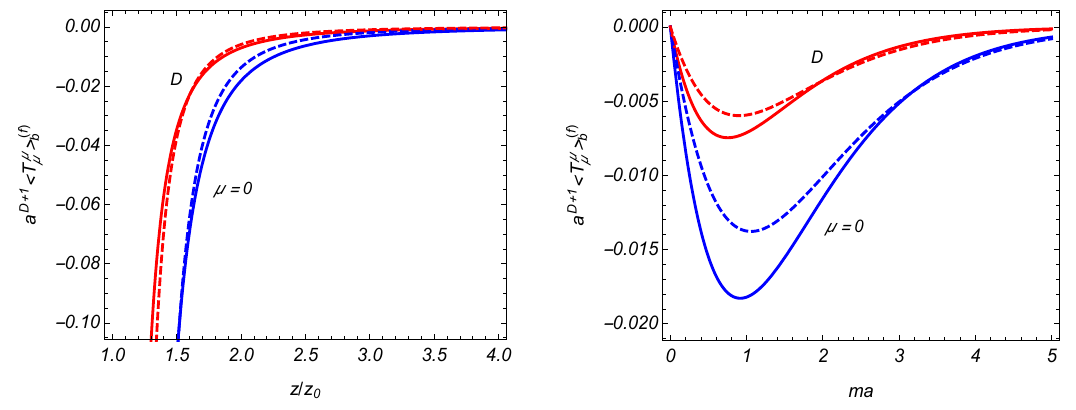
Figure 1. The brane-induced contributions in the VEVs of the energy density and the normal stress as functions: of z / z 0 ( left ); and of ma ( right ). For the left panel, we take ma = 1 and for the right panel z / z 0 = 2. The full and dashed curves correspond to D = 3 and D =